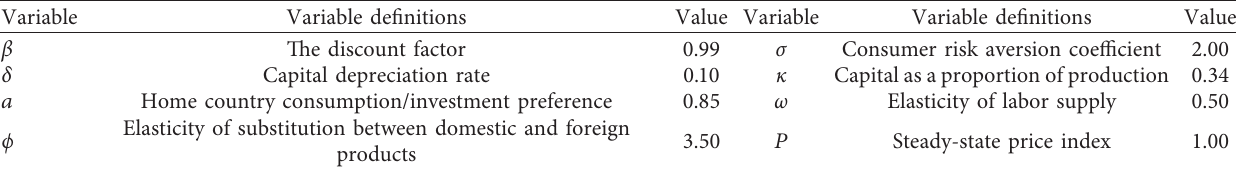
Table 5: Calibrated static parameters.